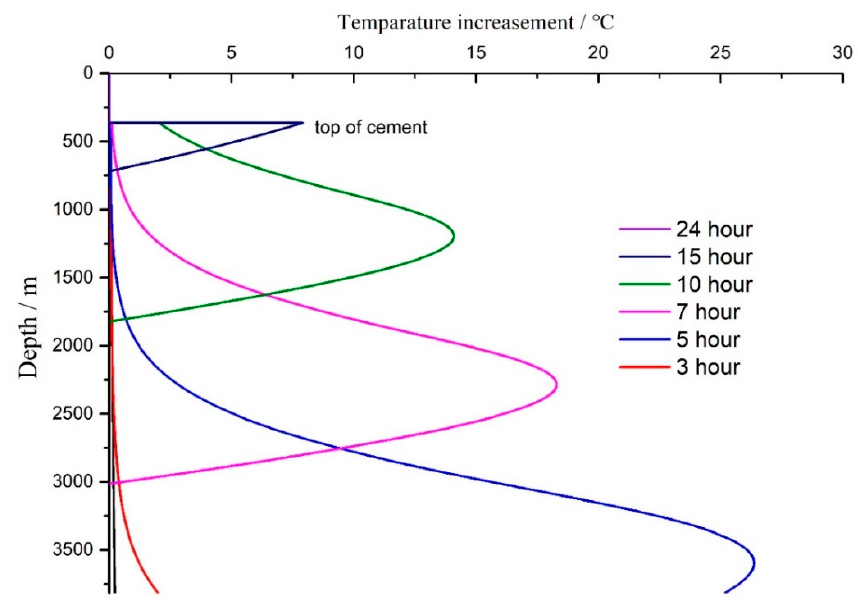
Figure 10. Cement temperature increasement in the wellbore.